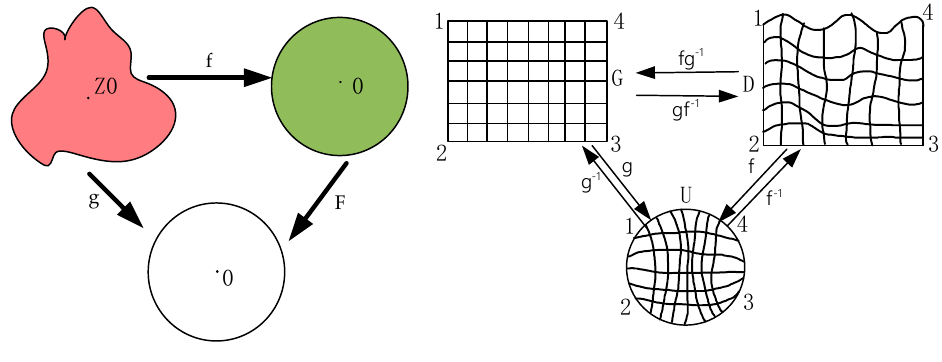
Figure 3. Riemann mapping theorem.